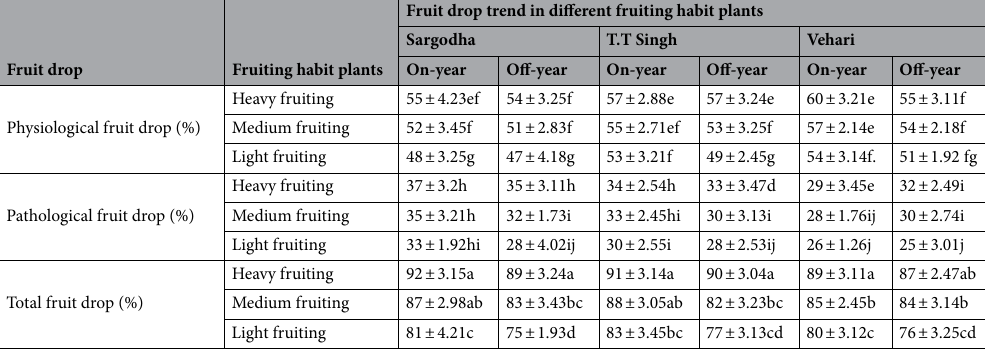
Fruit drop Physiological fruit drop (%)